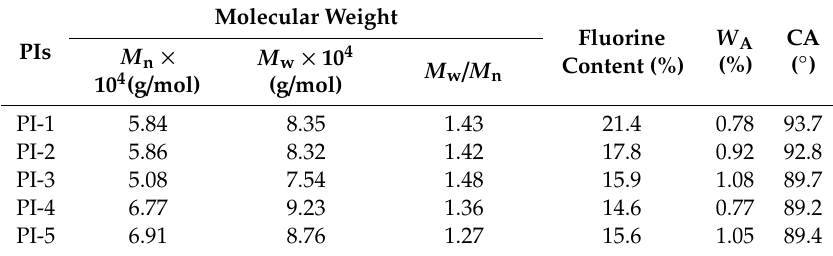
Table 1. Physical properties of semi-alicyclic polyimides a .